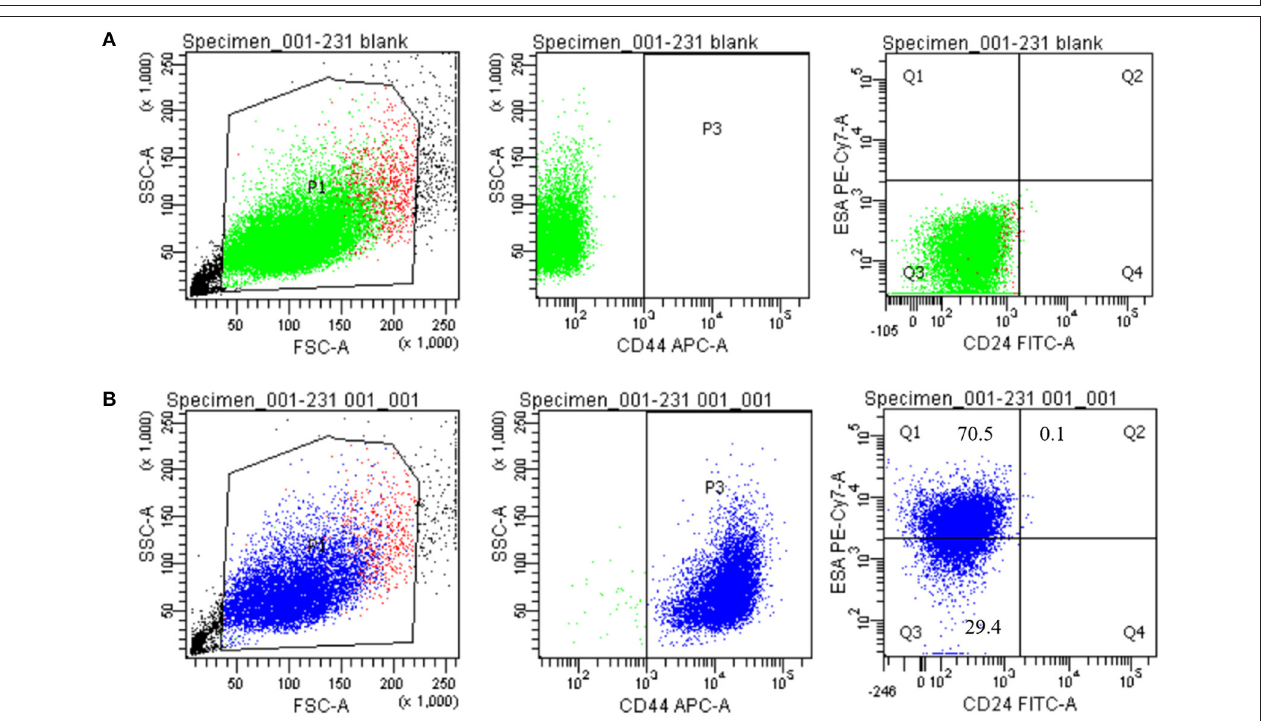
FIGURE 1 | The enrichment of MDA-MB-231 breast cancer stem cells with the method of “serum and serum-free alternation.” (A) The ordinary MDA-MB-231 breast cancer cells. (B) The MDA-MB-231 cancer stem cell microspheres formed after “serum and serum-free alternation” culture for 30 days, which are balloon shaped and suspended in the culture solution. Magnification, 10 × . (C) The MDA-MB-231 cancer stem cell microspheres. Magnification, 10 × .